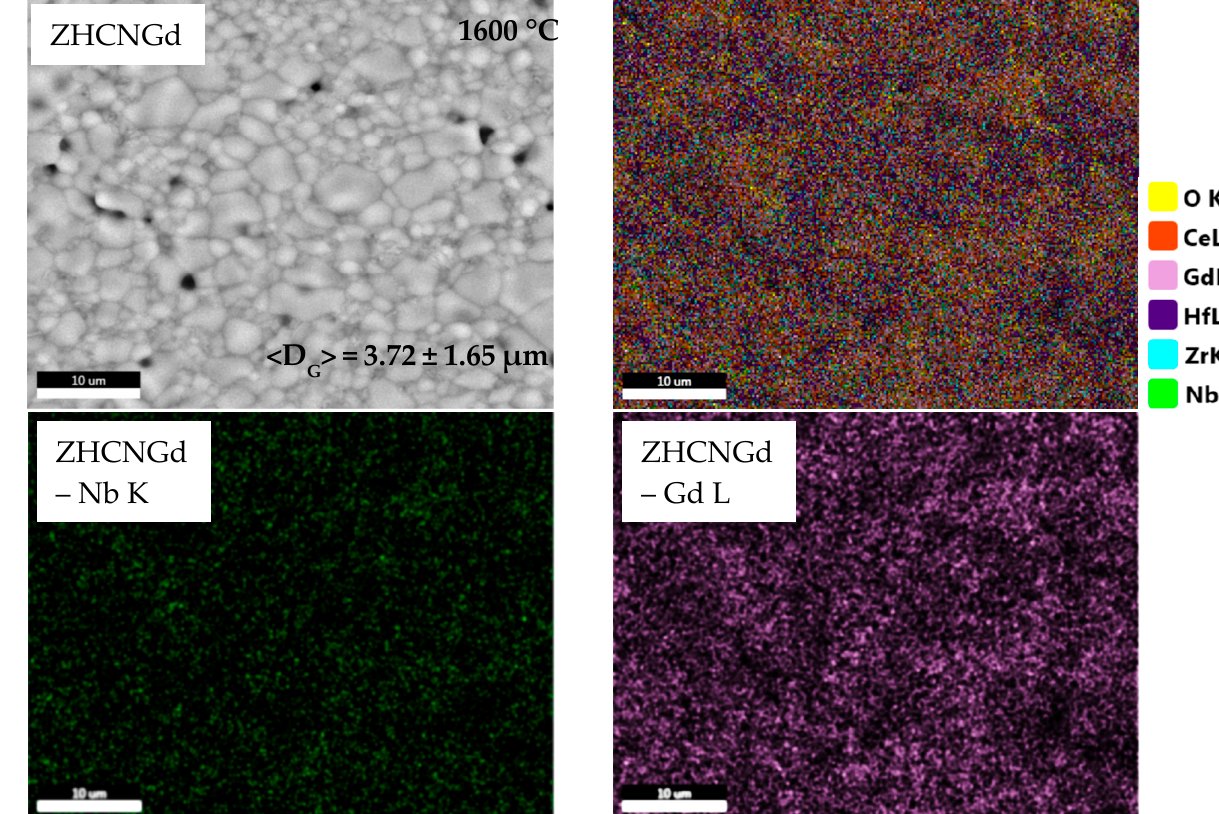
Figure 2. Microstructure and elemental distribution of samples treated at 1600 °C belonging to ZrO 2 -HfO 2 -CeO 2 -Nb 2 O 5 - Re 2 O 3 equimolar systems (Re = Y, Yb, Nd, Gd).